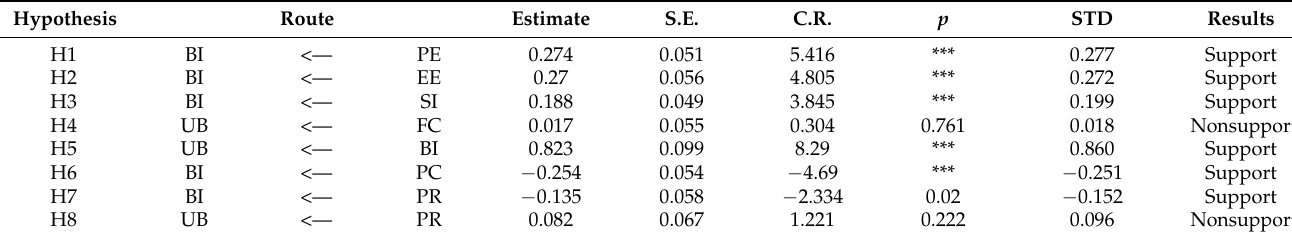
Table 9. Verification results of hypotheses.